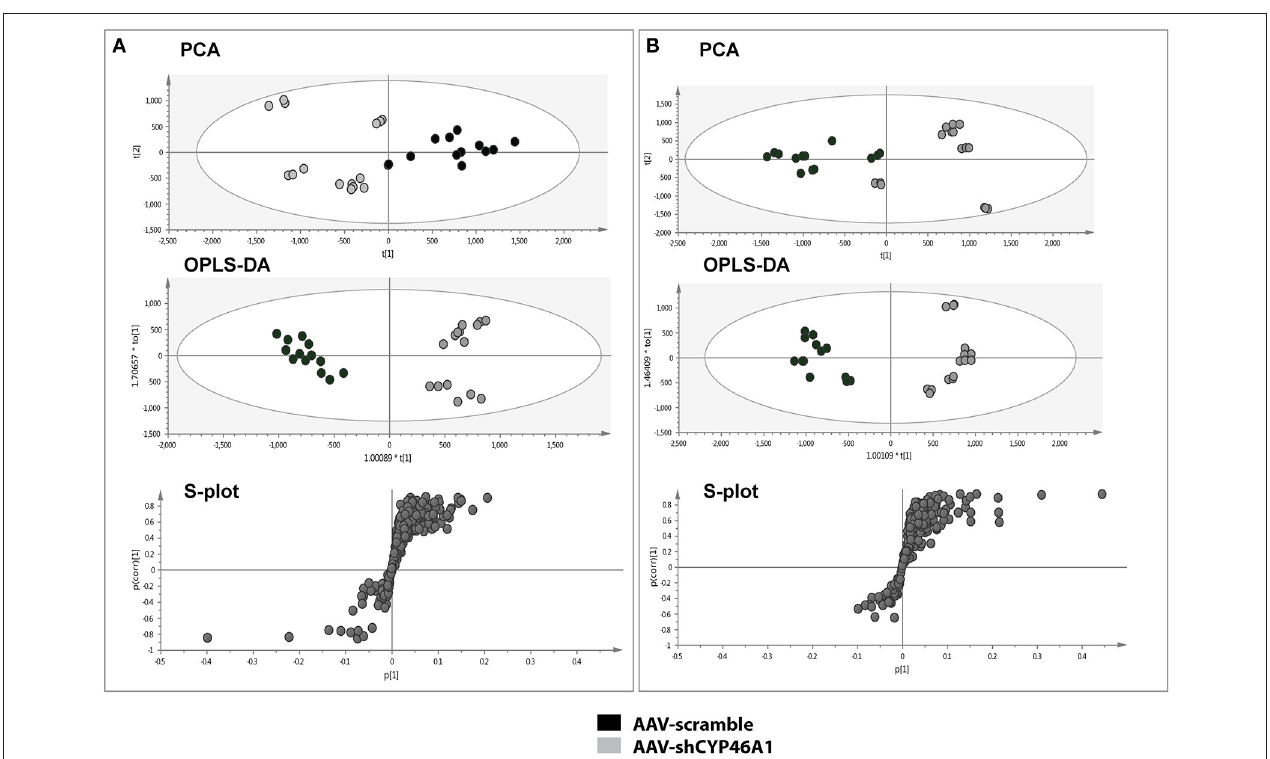
FIGURE 2 | Multivariate data analysis of AAV-scramble and AAV-shCYP46A1 hippocampus lipid data. After extraction, the lipid content of AAV-scramble (control) and AAV-shCYP46A1 hippocampus 4 weeks after injection were analyzed by UPLC-ESI-MS E . (A) PCA, OPLS-DA scores plots and OPLS-DA loadings S-plot for ESI + mode. For the PCA score plot, the principal component 1 (87%) and principal component 2 (5%) account for 92% of the variance. For the OPLS-DA score plot: one orthogonal and two predictive components, R2X(cum) = 0.837, R2Y(cum) = 0.947, Q2(cum) = 0.927 with a p -value, p = 7.27e-11. S-plot from OPLS-DA analysis emphasizes variables that strongly contributed to the class separation between the two groups. (B) PCA, OPLS-DA scores plots and OPLS-DA loadings S-plot for ESI- mode. For the PCA score plot, the principal component 1 (87%) and principal component 2 (4%) account for 91% of the variance. For the OPLS-DA score plot: one orthogonal and two predictive components, R2X(cum) = 0.757, R2Y(cum) = 0.953, Q2(cum) = 0.905 927 with a p -value, p = 1.14e-9. S-plot from OPLS-DA analysis emphasizes variables that strongly contributed to the class separation between the two groups. AAV-scramble and AAV-shCYP46A1 are represented by black and gray dots, respectively. Details of variables are shown in Tables 1, 2